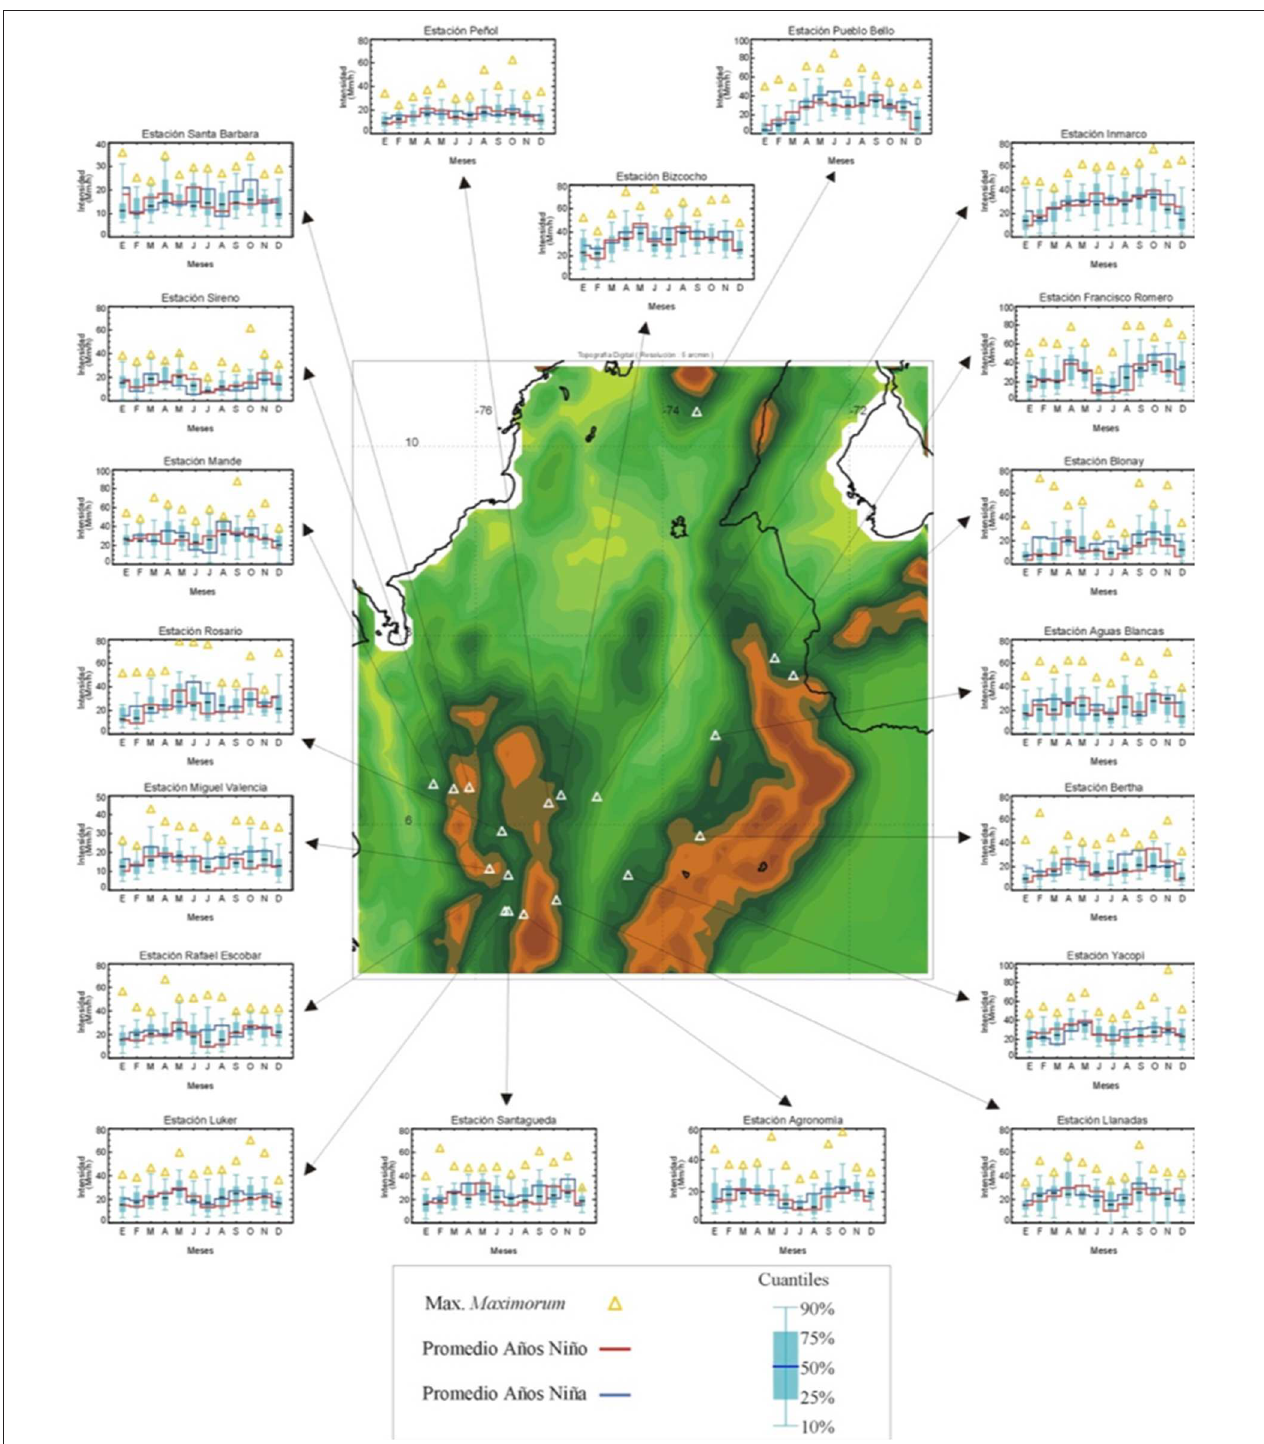
FIGURE 10 | Long-term mean annual cycle of the probability distribution function of 1h rainfall events, including average values during El Niño (red line) and La Niña (blue line), and maxima values (yellow triangles) recorded at selected rain gauges along the Colombian Andes. Source: Poveda et al. (2002).